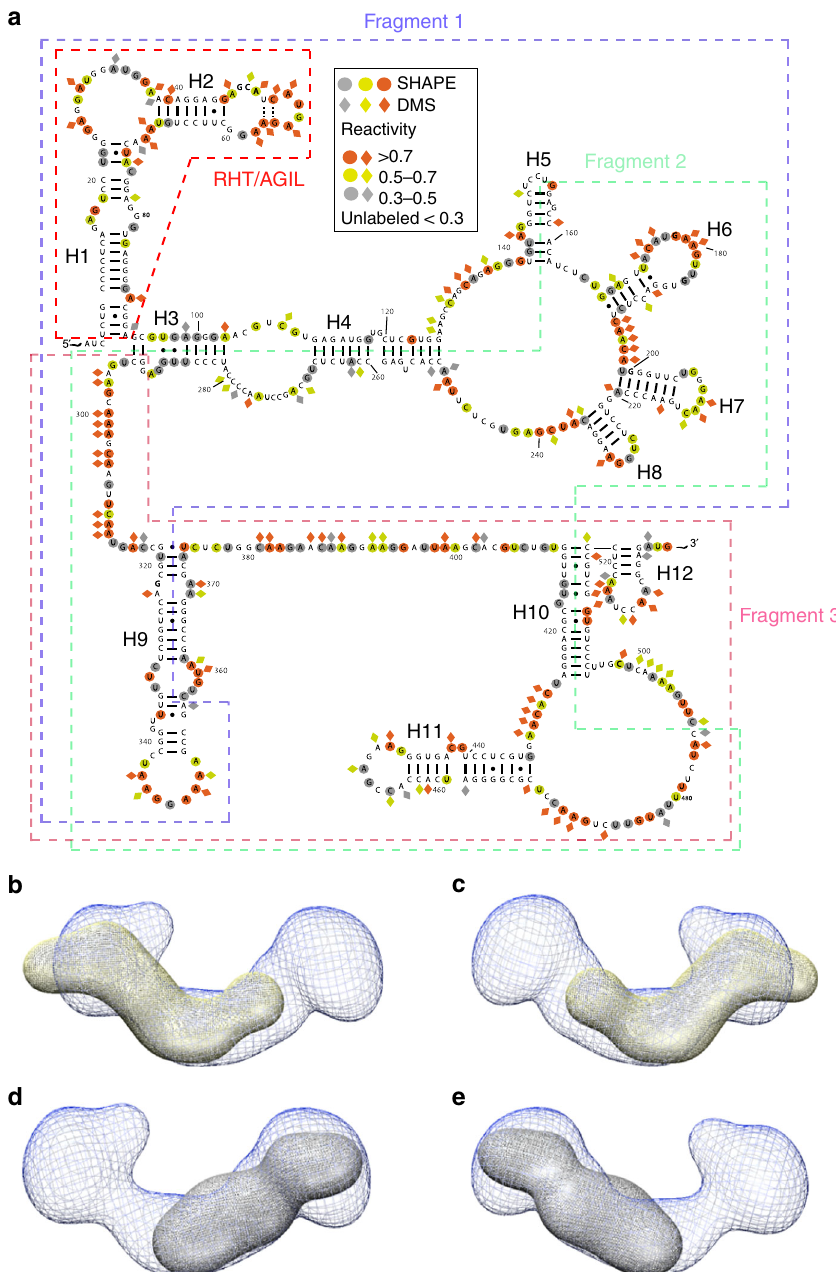
Fig. 4 Structural studies of Bvht overlapping fragments at 6 mM Mg 2 + . a Secondary structures of full-length Bvht and its overlapping fragments. b – e Averaged 3-D SAXS solution conformation of full length Bvht and its overlapping fragments. b Blue mesh, averaged solution structure of full-length Bvht ; yellow fragment 1 of Bvht . c 180° rotated view of ( b ). d Gray, fragment 3 of Bvht . e 180° rotated view of ( d